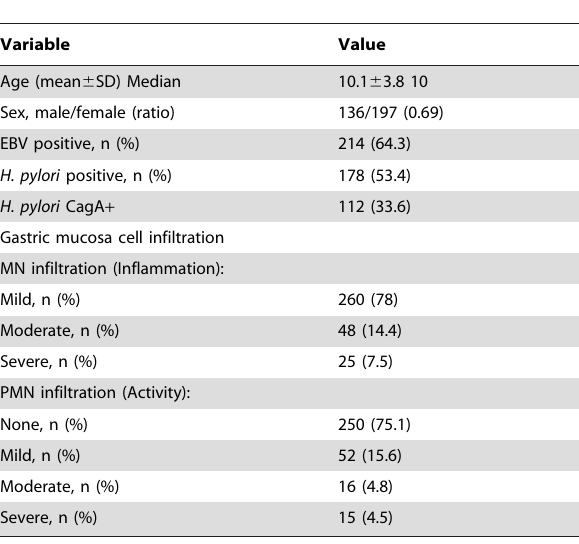
Table 1. Characteristics of the333 children studied.